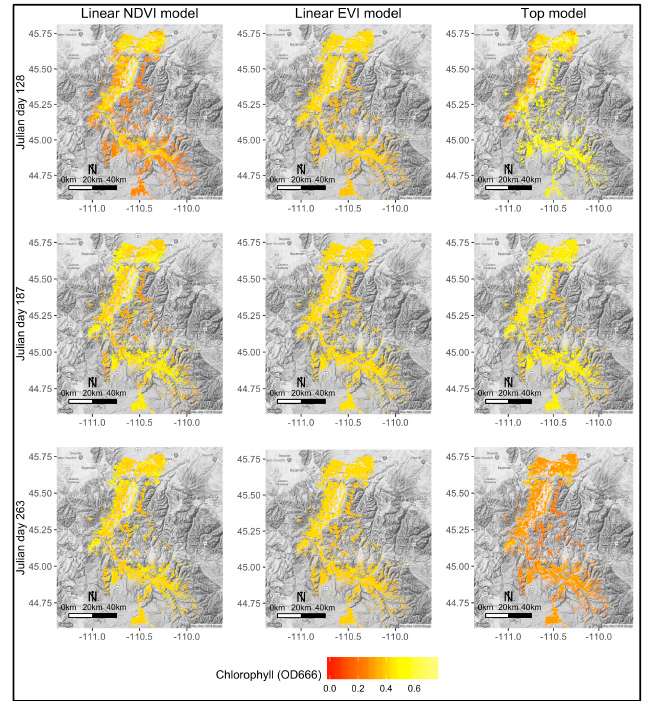
Figure 6. Maps of the chlorophyll (OD666) content of grasslands across the Upper Yellowstone River Basin on Julian days 128, 187, and 263 estimated from the linear NDVI, linear EVI, and the top models.